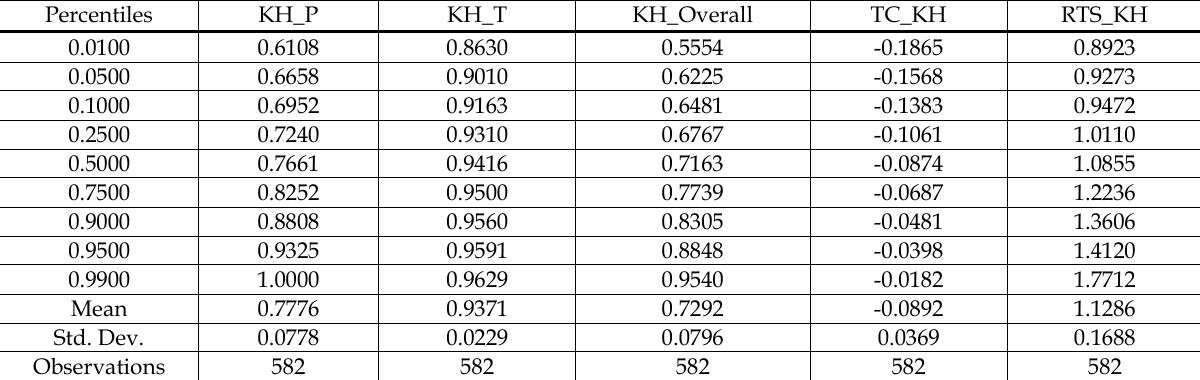
Results from Model 1